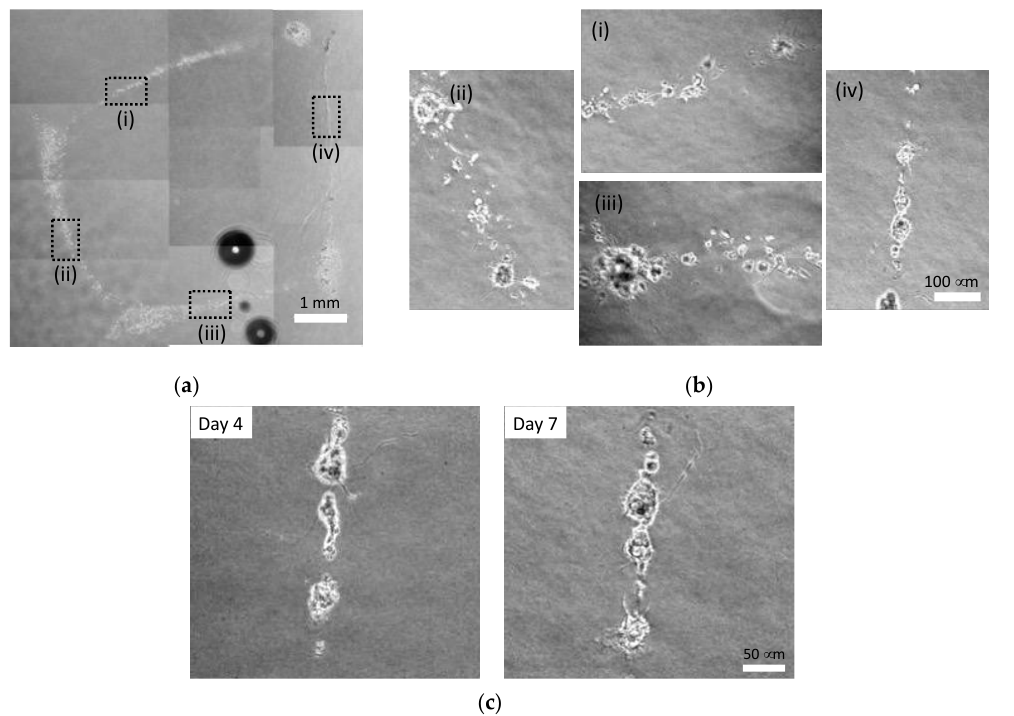
Figure 9. Phase-contrast images of square pattern of PC-12 cells injected at 0.096 mL/s in atelocollagen gel. ( a ) Gross image, ( b ) enlarged images of (i) Line 1, (ii) Line 2, (iii) Line 3 and (iv) Line4 of square pattern on day 7; ( c ) Neurite growth during the culture time.